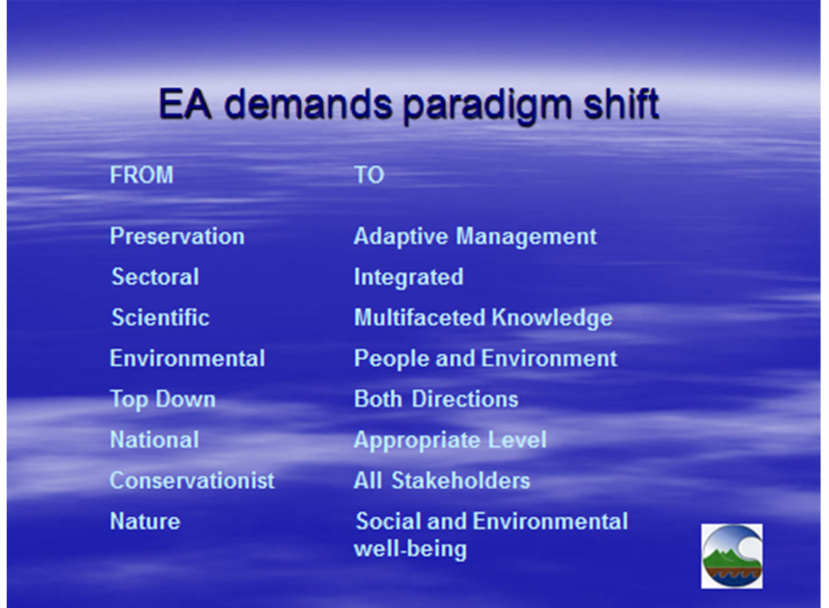
Figure 22. Summary of the key changes in thinking required to effectively apply the ecosystem approach